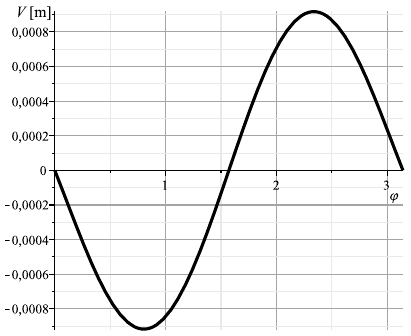
Figure 6: Plot of V ( φ ) (Example 5.1).